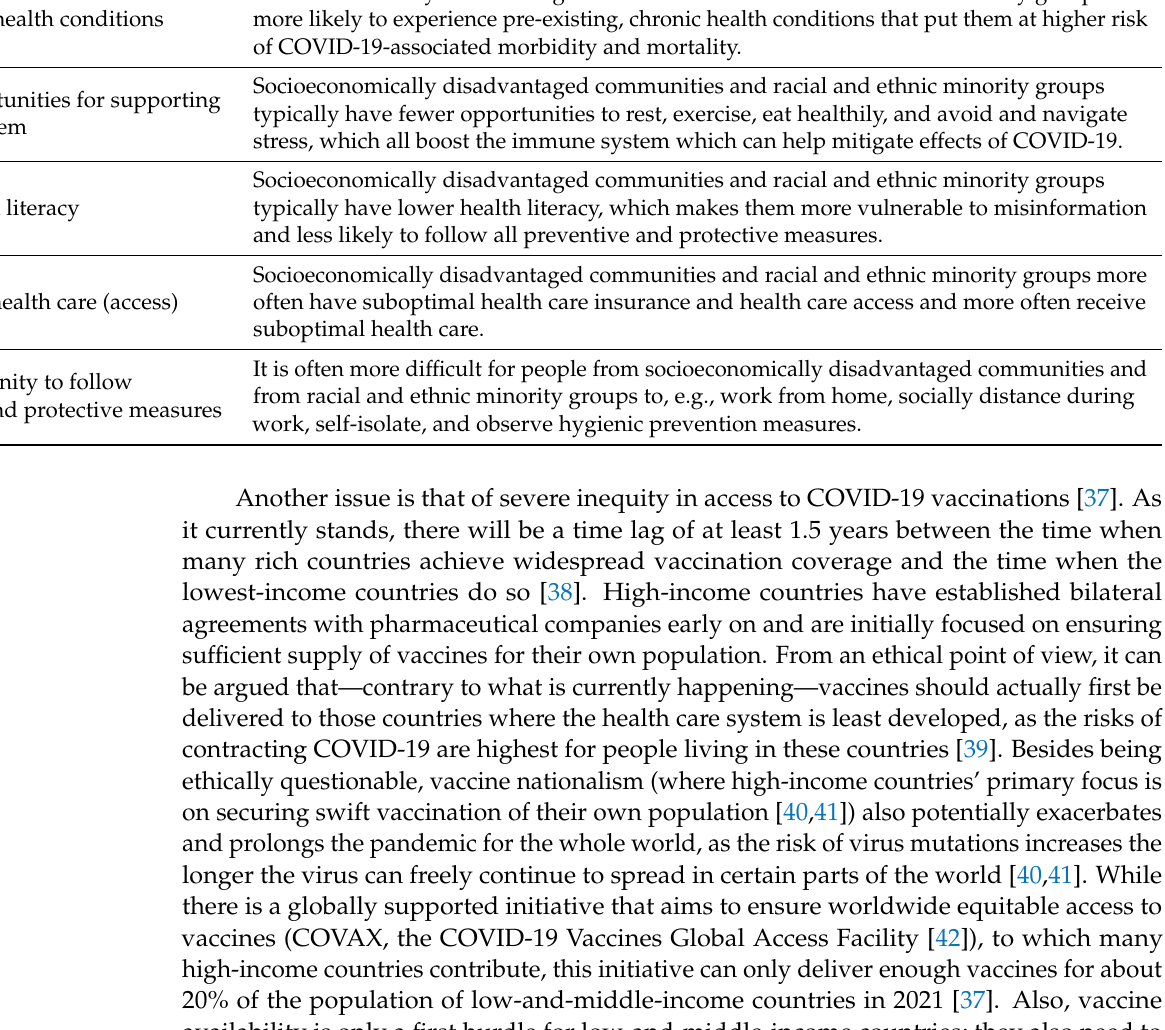
Table 1. Schematic overview of reasons for social inequalities in impact of COVID-19. Reason for Inequality Brief